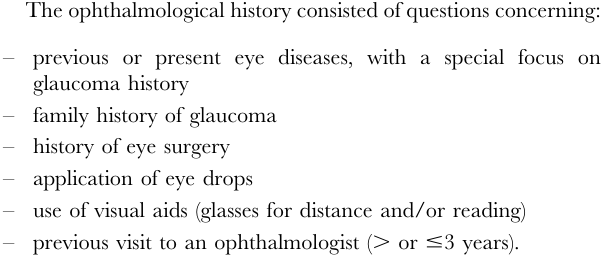
Sites of Evonik Industries